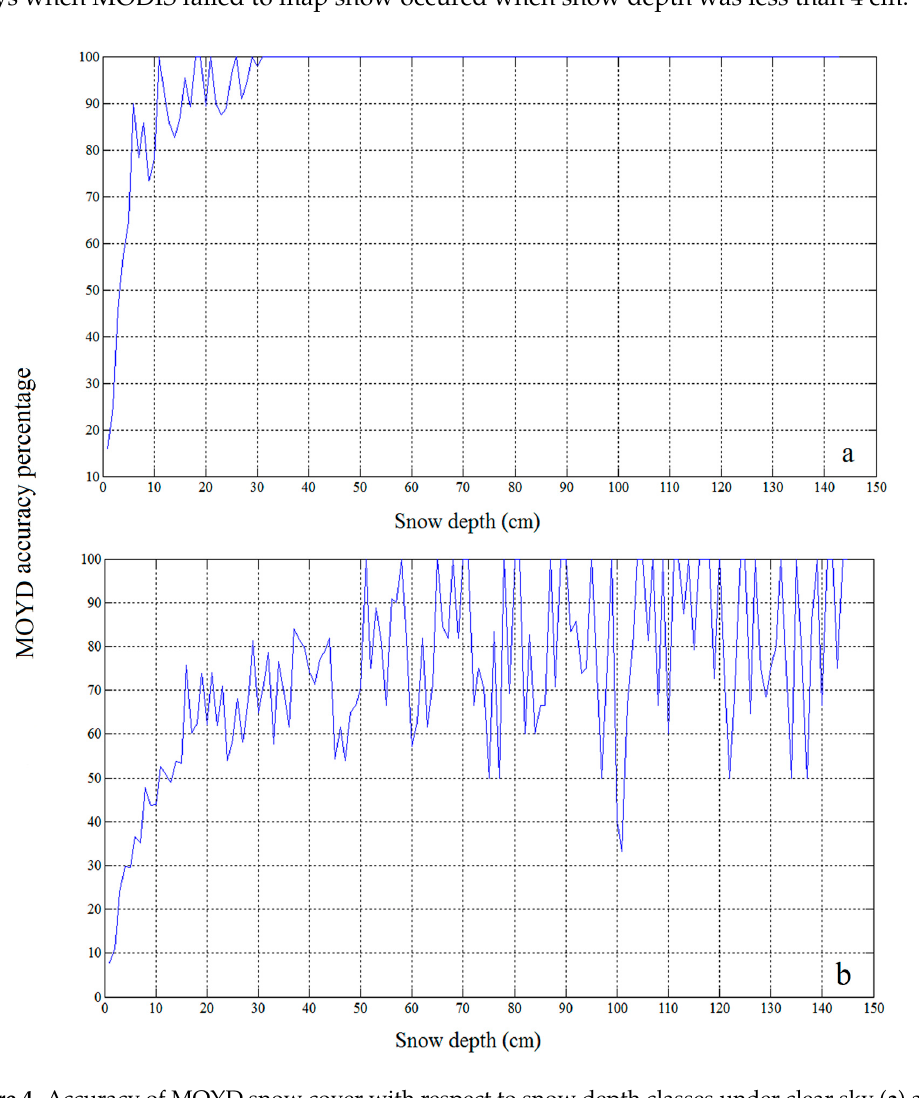
Figure 4. Accuracy of MOYD snow cover with respect to snow depth classes under clear sky ( a ) and under clear and cloudy sky ( b ). The accuracy percentage is 100% for clear sky conditions when the snow depth is greater than 35 cm.